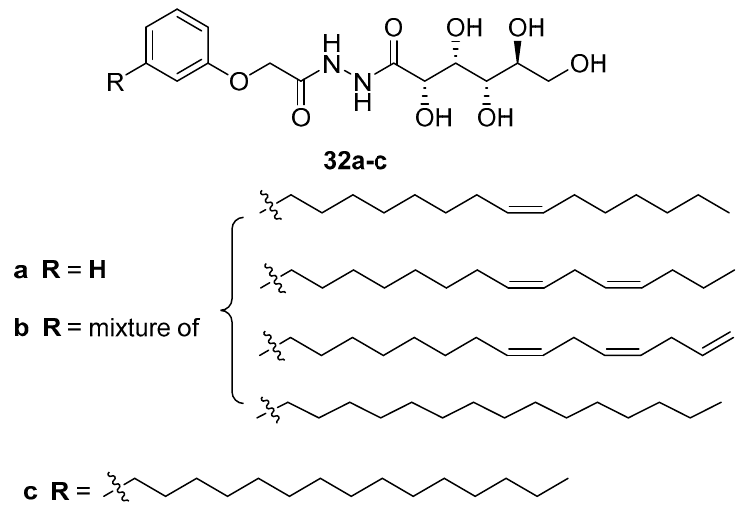
Figure 23. Gluconamide-based gelators [68].